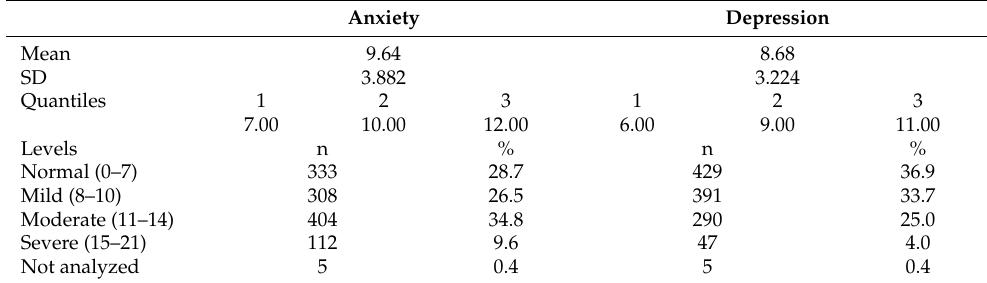
Table 2. The Hospital Anxiety and Depression Scale scores and